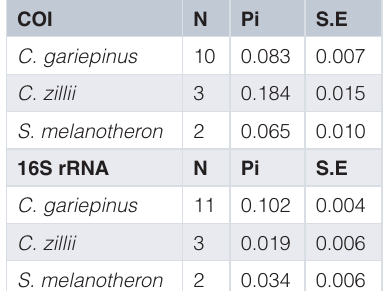
Table 4. Genetic intraspecific mean variability in C. gariepinus , C. zillii and S. melanotheron . N: the number of sequences; Pi: nucleotide diversity within the population; H: number of different sequences types; K: average number of nucleotide differences within the